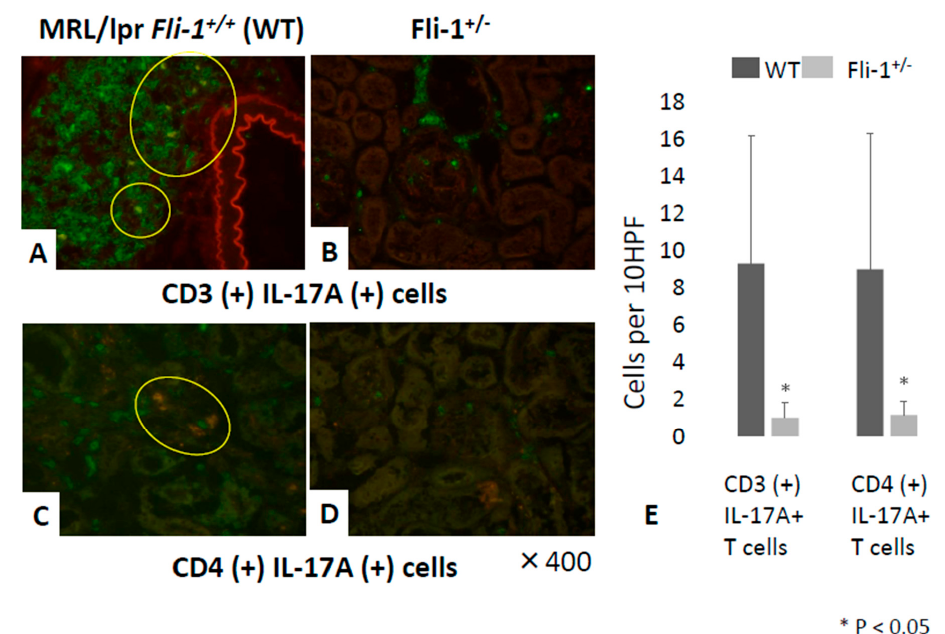
Figure 4. Detection of CD3 + IL-17A + and CD4 + IL-17A + immune cells in the kidney of MRL / lpr Fli-1 +/+ (WT) and MRL / lpr Fli-1 +/ − mice using FITC-conjugated anti-CD3, anti-CD4, and Alexa Fluor 647-labeled IL-17 antibodies. Detection of CD3 + IL-17A + and CD4 + IL-17A + cells in renal tissue from WT MRL / lpr and MRL / lpr Fli-1 +/ − mice (4 months old or older) is shown ( A – D ). Cell counts of CD3 + IL-17 + and CD4 + IL-17 + leukocytes and total counts from ten random high-power fields (HPFs) ( n = 6–10 per groups) are shown ( E ); * p < 0.05 is considered as significant. Cells 2020 , 9 , x